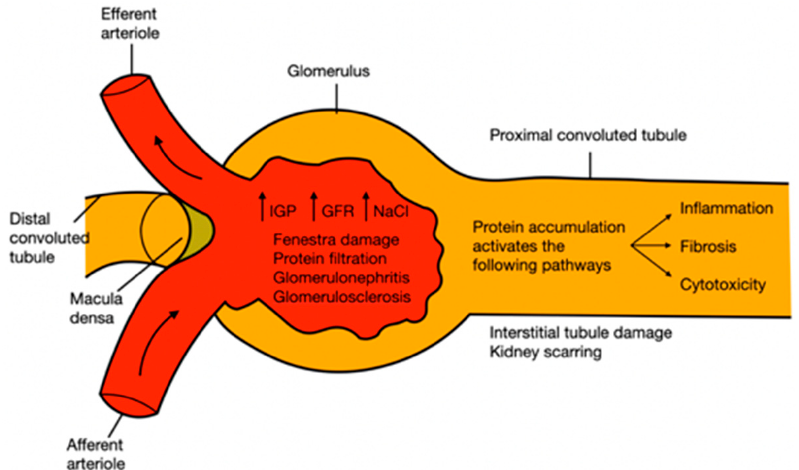
Figure 3. Pathophysiology of kidney damage induced by hypertension. IGP: intraglomerular pressure; GFR: glomerular filtration rate; NaCl: sodium chloride.